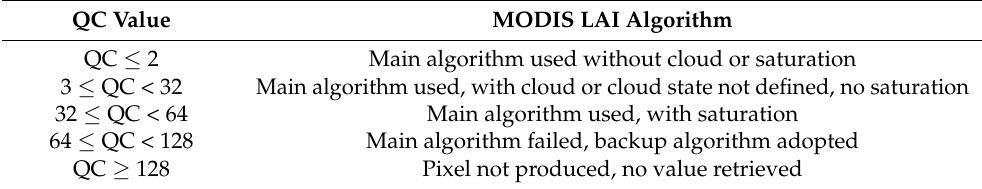
Table 1. Classifications of quality control information of MCD15A2H C6.1 LAI product. QC